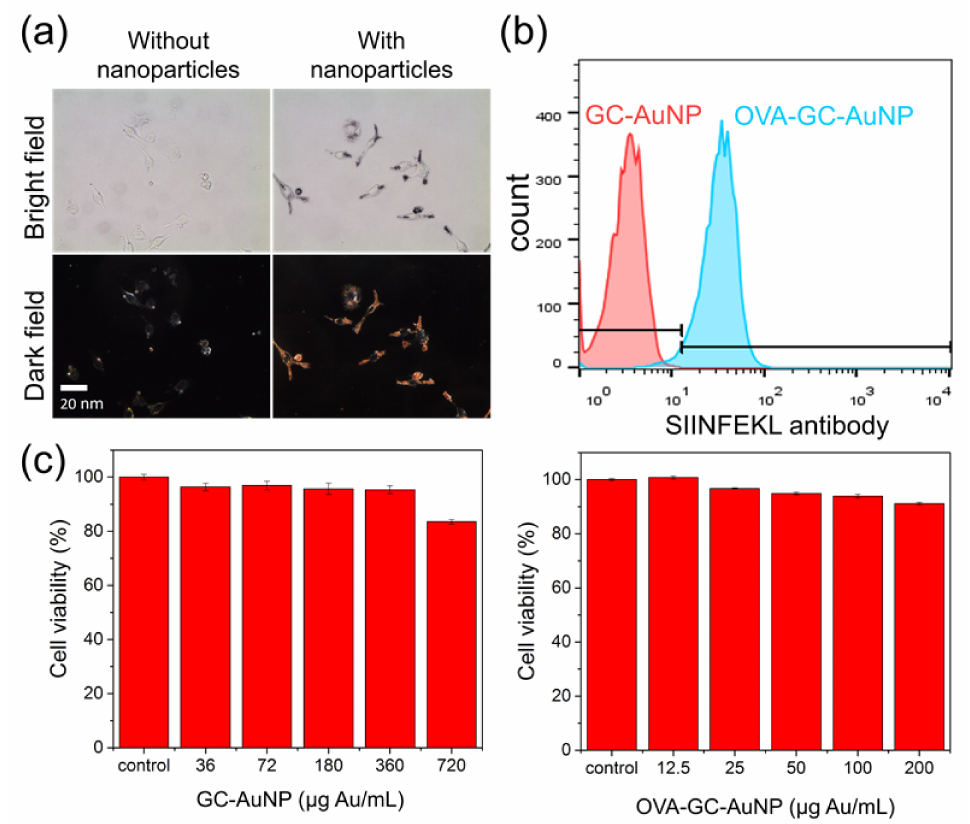
Figure 2. ( a ) Bright- (top) and dark-field (bottom) images of macrophages (J774.A1) after incubation without (left) and with (right) GC-AuNPs. Cells were incubated for 4 h with GC-AuNPs before fixation; ( b ) The expression of OVA epitope on macrophages after the cellular uptake of OVA-GC- AuNP (100 µ g Au/mL), measured with flow cytometry; ( c ) Cytotoxicity of GC-AuNPs (left) and OVA-GC-AuNPs (right) according to the